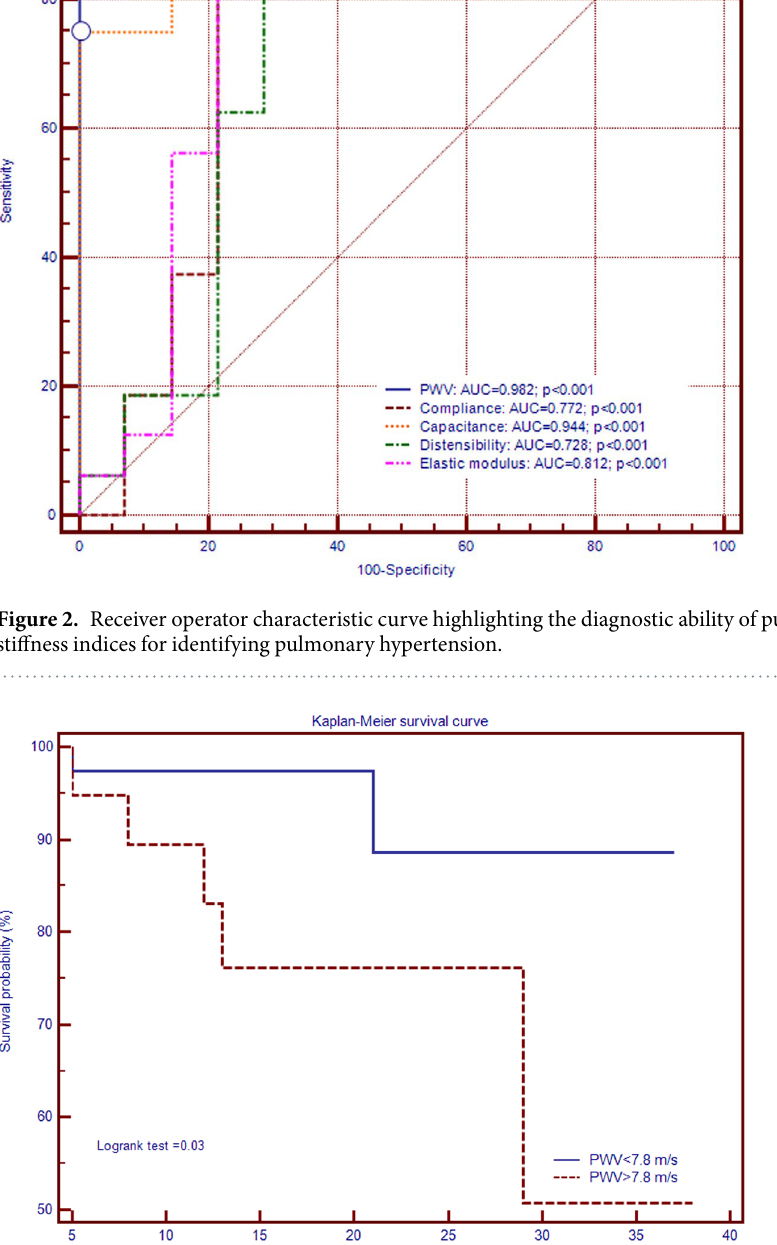
Sample size estimation. For assuring a 95% confidence, and 80% power of the study and based on the dif- ference in MACE between groups, we have calculated a minimum required sample size of 40 patients in the test group for testing the ability of cardic MRI derived parameters to identify patients at risk for MACEs.